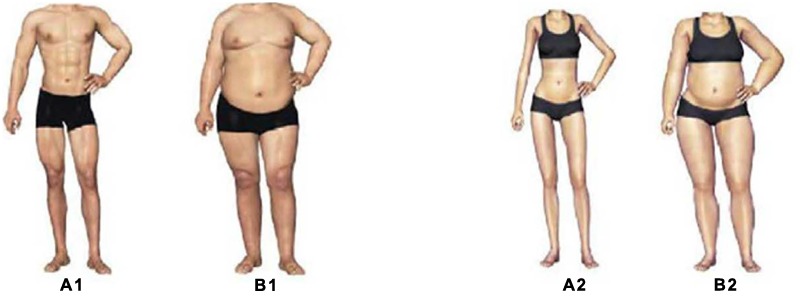
Sample of high and low attractiveness bodies used in this study. A1 and A2 are high attractiveness bodies, and B1 and B2 are low attractiveness bodies.